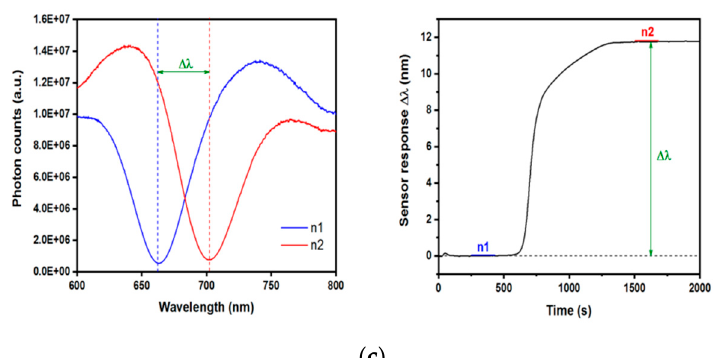
Figure A1. Custom-designed SPR biosensor. ( a ) Photograph of the experimental SPR set-up. ( b ) Scheme of the sensing principle of a SPR biosensor. ( c ) Graph showing the displacement of the resonance peak ( ∆ λ ) to RI changes (photon vs. λ (nm)). Real-time monitoring of wavelength displacements ( ∆ λ vs. time (s)).